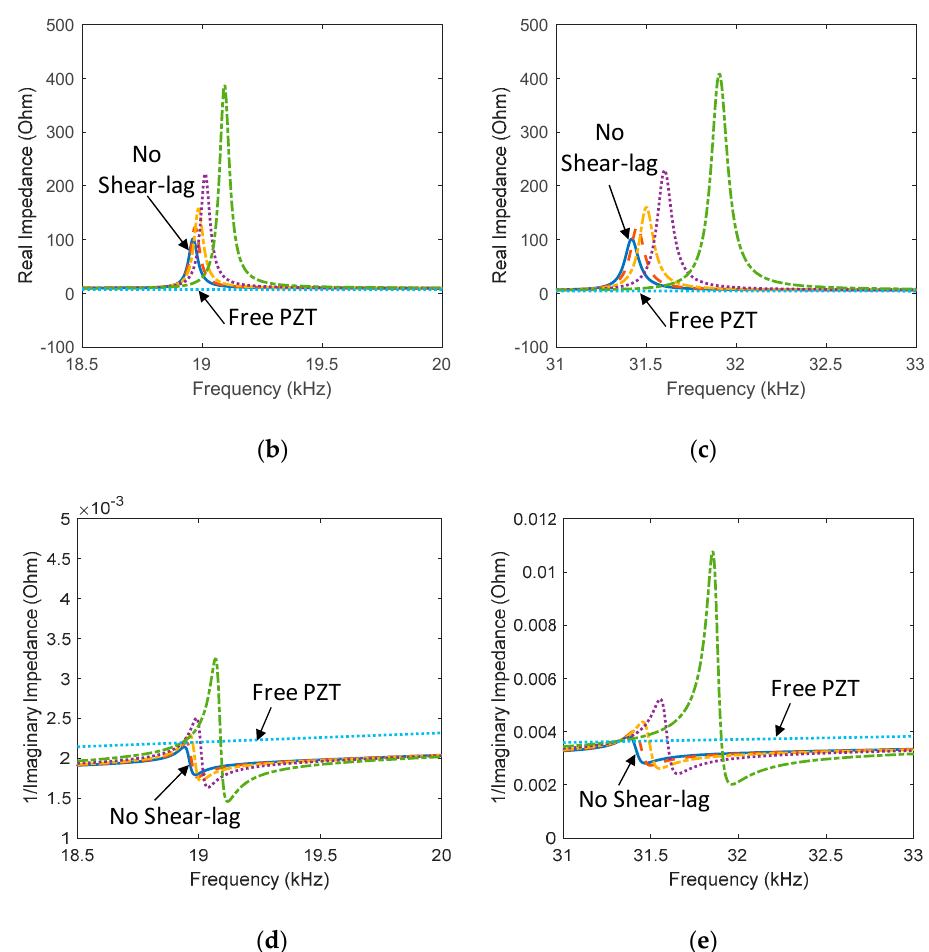
Figure 10. Analytical impedance signatures under the shear-lag effect: ( a ) real part in 10–50 kHz; ( b ) real part in 18.5–20 kHz; ( c ) real part in 31–33 kHz; ( d ) imaginary part in 18.5–20 kHz; ( e ) imaginary part in 31–33 kHz.